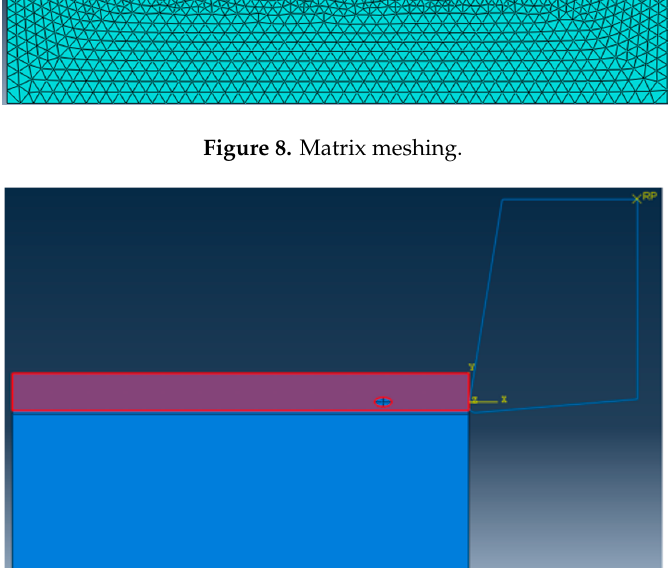
Figure 9. Contact setting of tool and cutting layer.